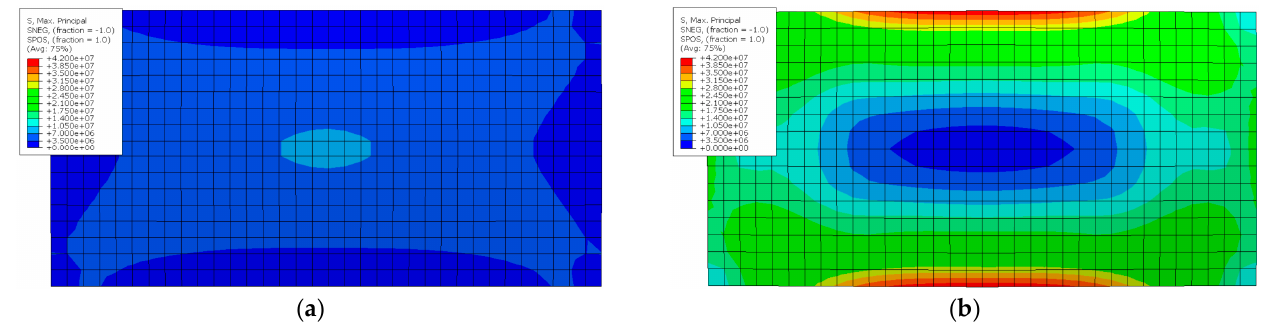
Figure 6. Maximum principal tensile stress (‘summer’ load case) for: ( a ) flat IGU; ( b ) curved IGU. Note: Bottom view; values in MPa; the same scale was used for the legend on both figures (max: 42 MPa). Table 3. Results of the case